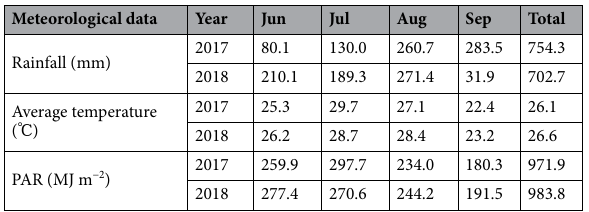
Table 5. Monthly rainfall, monthly photosynthetically active radiation (PAR) and daily average temperature at the experimental field in 2017 and 2018. PAR was estimated by multiplying solar radiation by